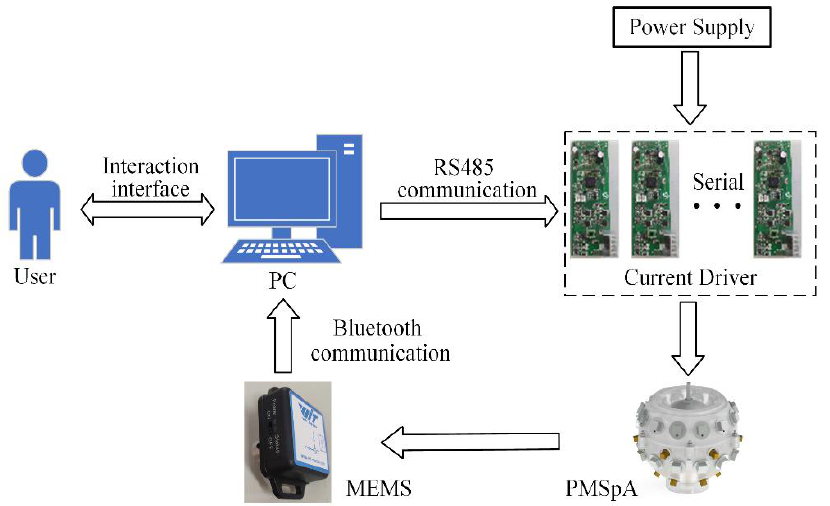
Figure 11. The principle of experimental operation.